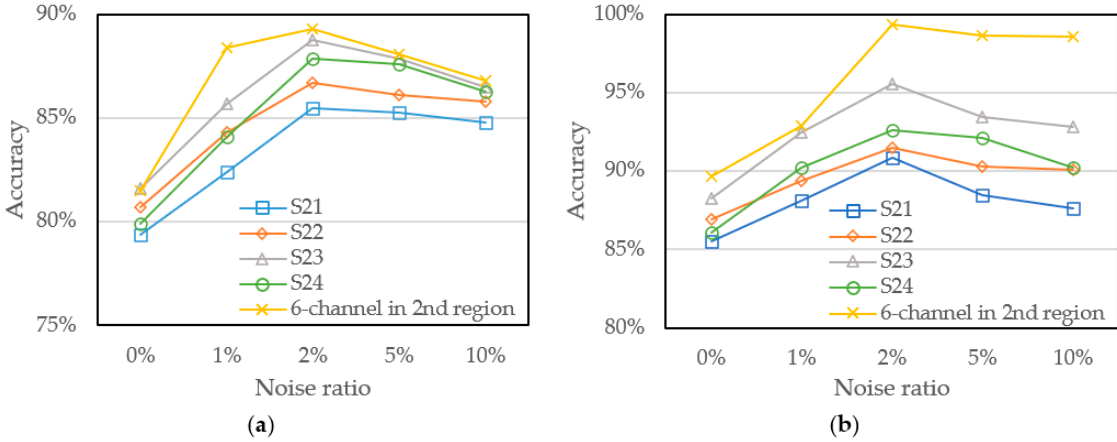
Figure 10. Model accuracy trained with divided 1st region and noise addition ( a ) GridsearchCV and ( b ) Bayesian optimization.